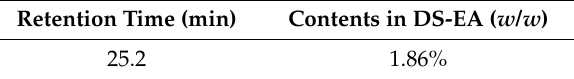
Table 3. The contents of α -spinasterol-3-O- β -D-glucopyranoside in Dianthus superbus -EtOAc soluble fraction